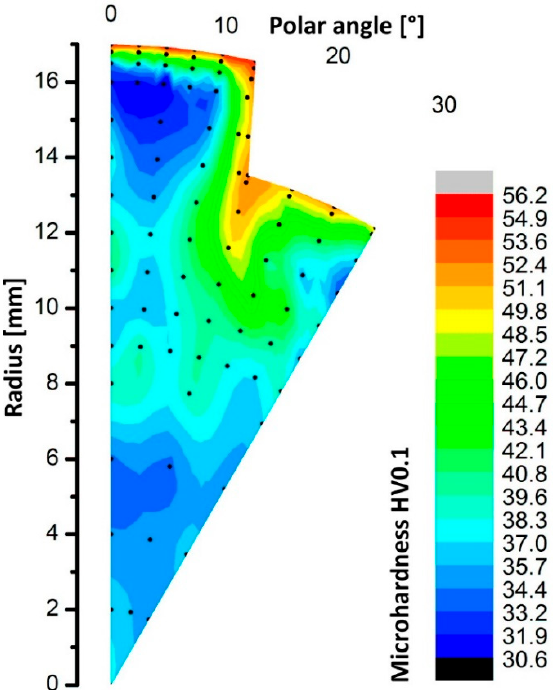
Figure 8. Grain size in the 30° segment of the gear-like element: ( a ) grain size zones (the midpoint of the zone is approximately indicated by arrows; polarized LM); ( b ) distribution of the mean grain diameter (black dots represent the position of measurement in polar coordinates; OriginPro8.6, Polar Contour Plot).